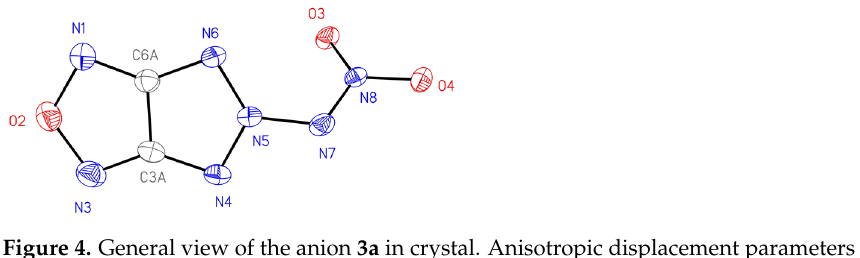
Figure 4. General view of the anion 3a in crystal. Anisotropic displacement parameters are drawn at a 50% probability level. a 50% probability